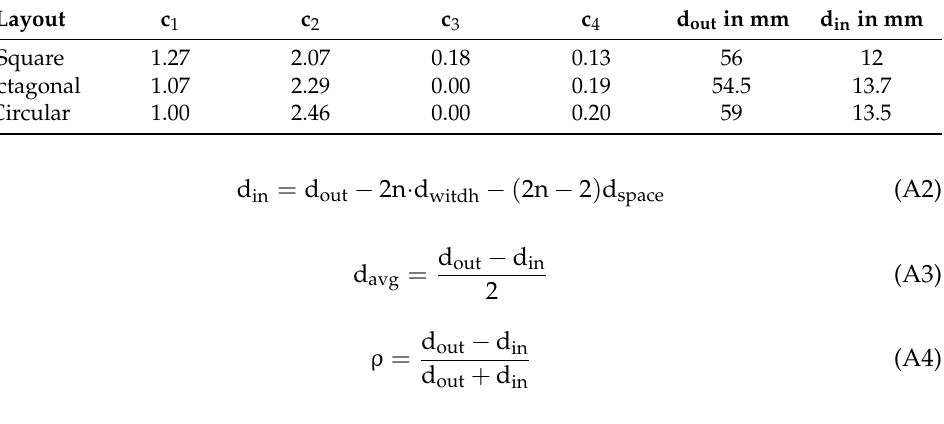
Table A1. Parameters for the calculation of inductance for the different coil geometries.